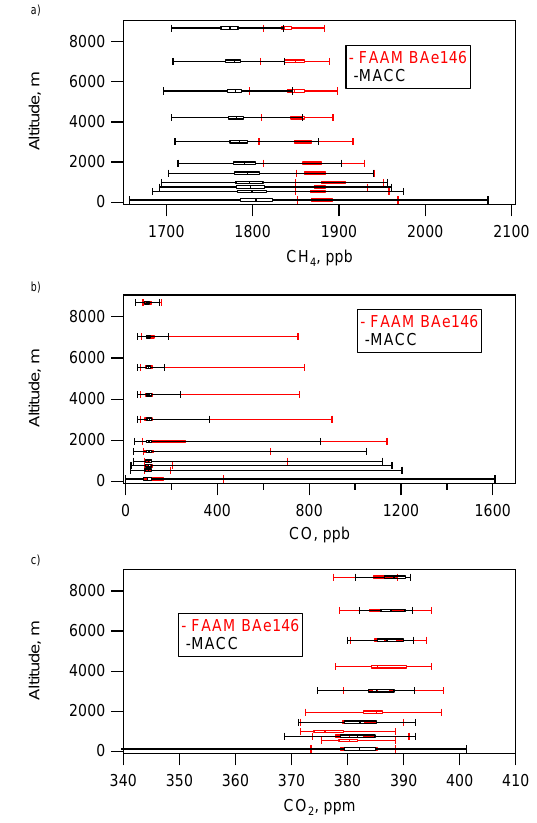
Fig. 4. Comparison between in situ measurements on the FAAM BAe-146 and those derived from the Monitoring Atmospheric Com- position and Change (MACC) project over the BORTAS sampling domain and period. Boxes are the 25th and 75th percentiles, the whiskers are the maximum and minimum